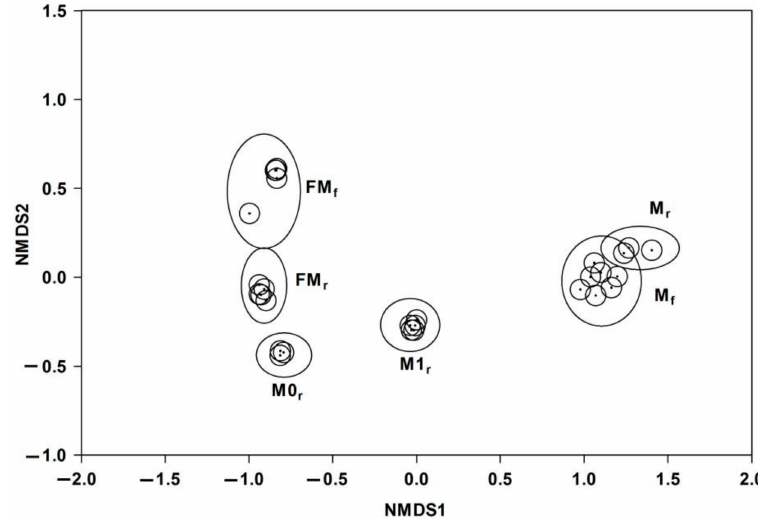
Figure 3. Score plots from nonmetric multidimensional scaling (NMDS) of floral scents in male and female flowers of the two Breynia species studied.